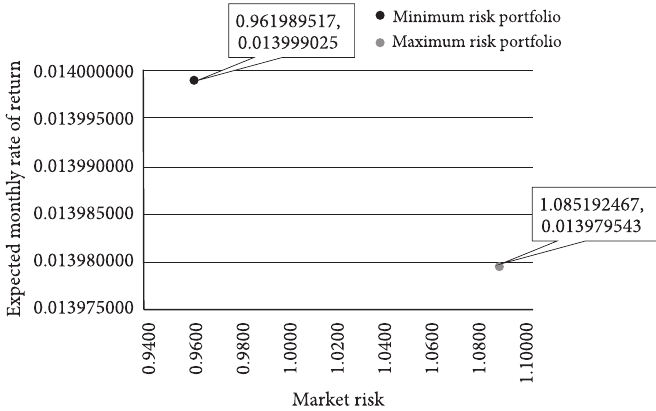
Figure 3. Reverse risk return relationship (the sample size is 50; weight constraint is 0.05; the interval is